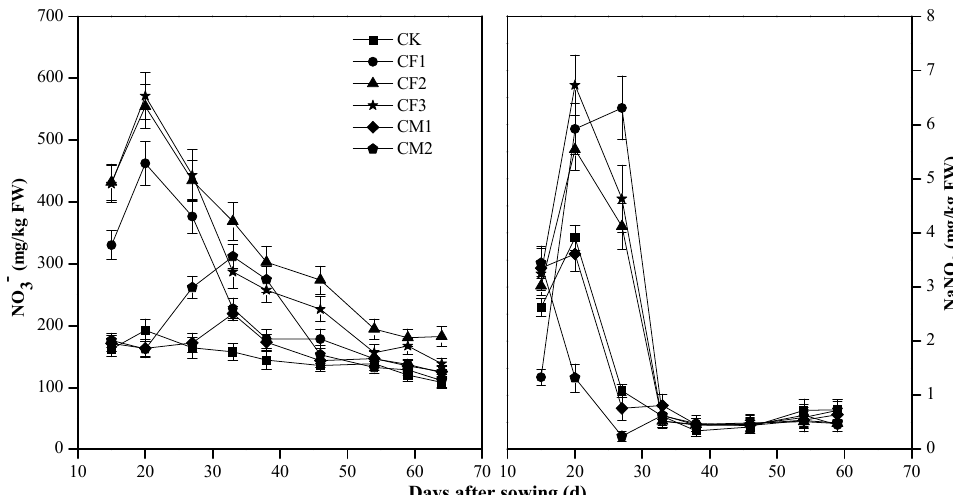
Figure 1. Variations of nitrate ( Left ) and nitrite ( Right ) contents in the water spinach ( Ipomoea aquatica Forssk. ) for the different fertilizer treatments during the growing season of the field experiment. CF1—chemical fertilizer in a low amount; CF2—chemical fertilizer in a moderate amount; CF3—chemical fertilizer in a high amount; CM1—cake manure in a low amount; CM2—cake manure in a high amount; CK—unfertilized control.